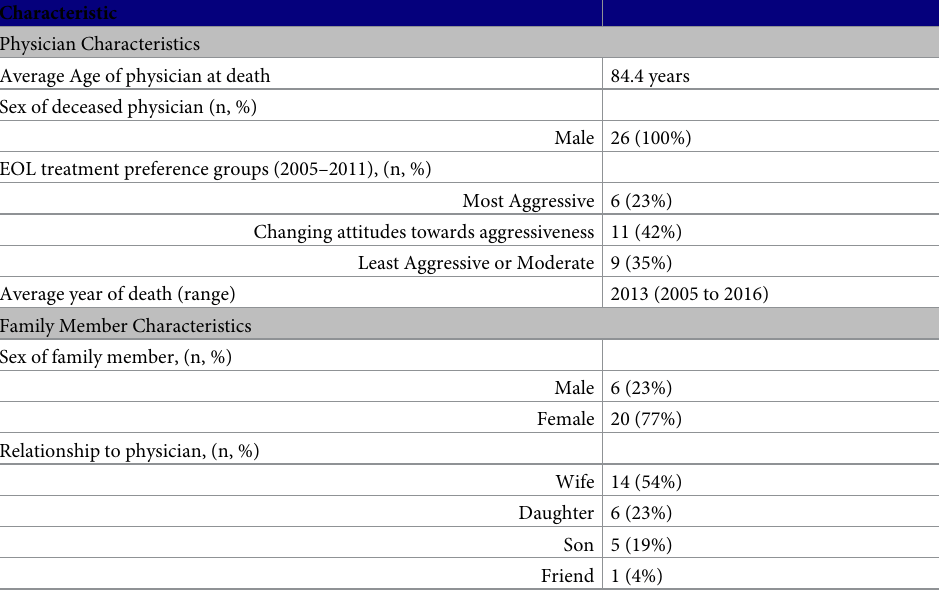
Table 1. Characteristics of deceased physician-patients and their family members (N = 26 Deceased Physician patients and 26 Family Members).